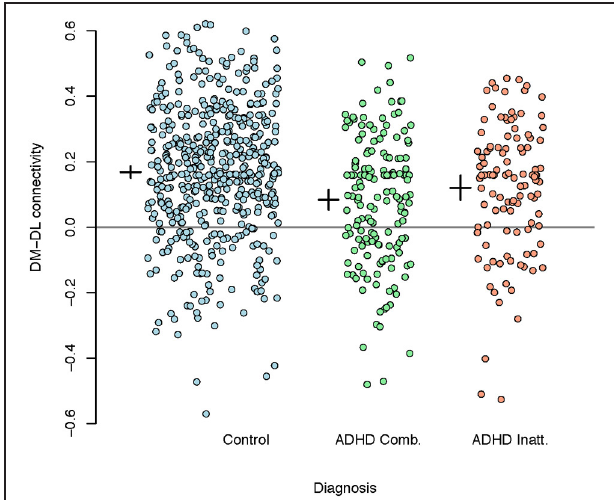
FIGURE 7 | Plot of correlations between the dorsomedial and dorsolateral M1 parcels by disease subtype. A reference line is drawn at zero while the inter-subject means (small horizontal line) and 95% confidence intervals (small vertical lines) are given to the left of each